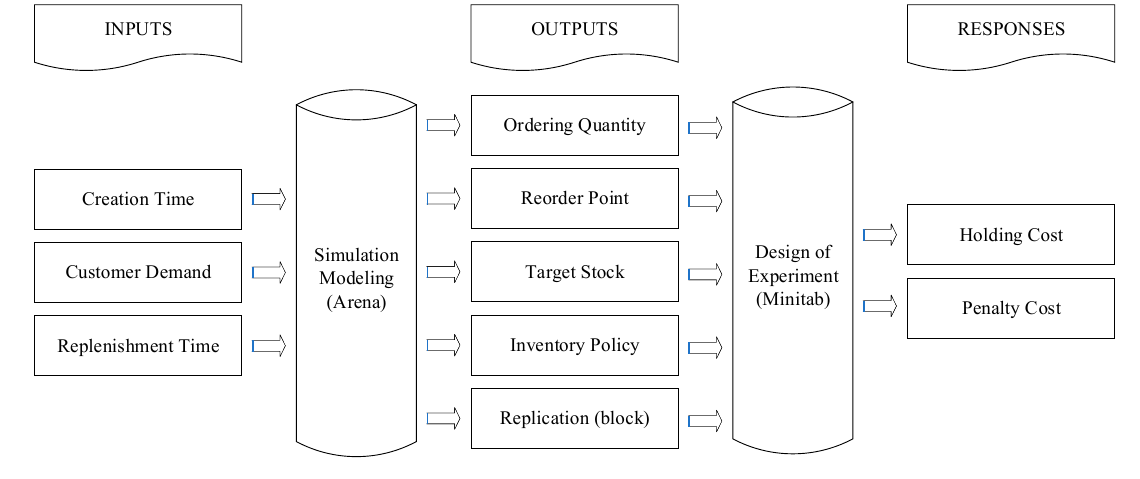
Figure 3. Computational model concept.